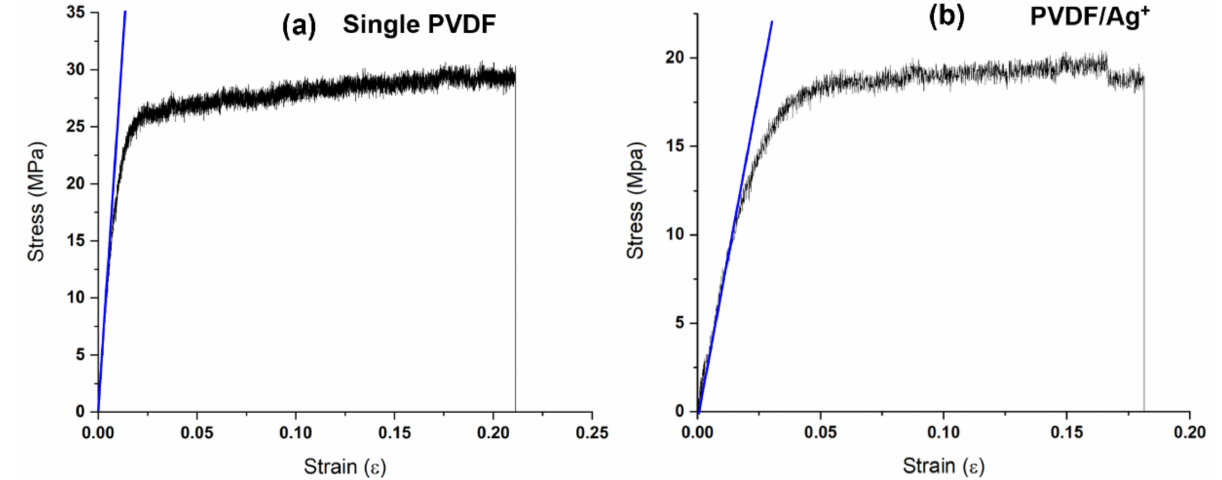
Figure 11. Stress-strain curves of the as prepared fibers: ( a ) single PVDF and ( b )